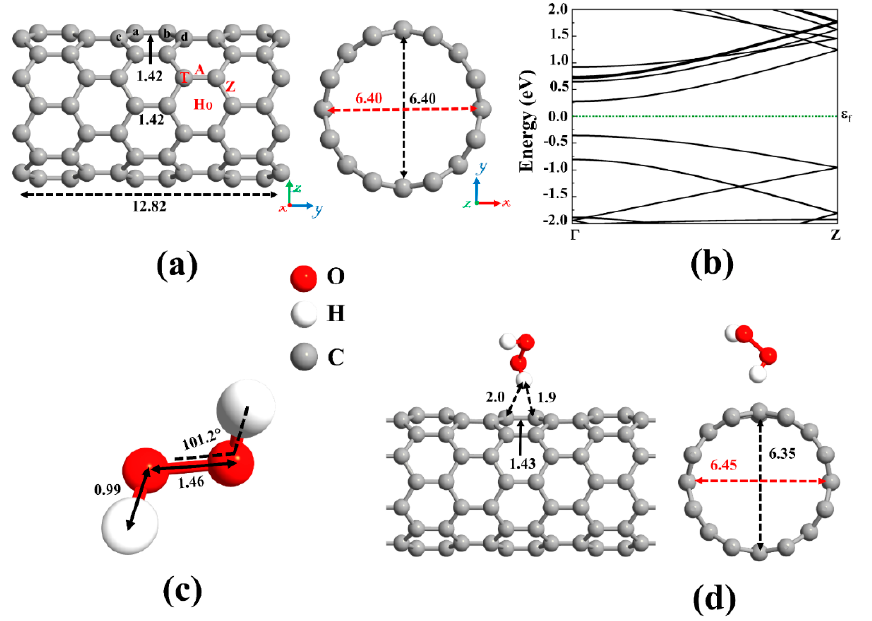
Figure 2. ( a ) Optimized structure of a pristine (8,0) single-wall carbon nanotube (SWCNT) and ( b ) its corresponding energy band structure, showing semiconducting behavior with an energy bandgap of 0.643 eV. The dotted green line indicates the Fermi level, which is set to zero. Di ff erent adsorption sites on an SWCNT (Ho: hollow, A: axial, Z: zigzag, and T: top). ( c ) The optimized molecular structure of Hydrogen peroxide (H 2 O 2 ). ( d ) The most stable adsorption configuration of H 2 O 2 on pristine SWCNT. Distances are given in the unit of Å. The red and black dotted arrows present the diameter of the nanotube parallel and perpendicular orientation to the axis of the nanotube,